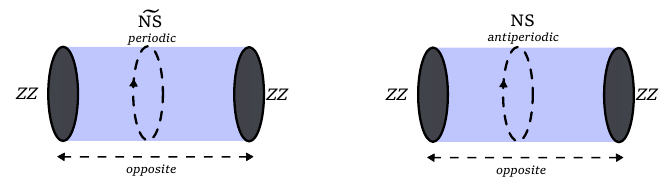
Figure 12 . Left: cylinder with g NS boundary conditions around the small circle, leading to super- symmetric quantum mechanics in 1d. Right: cylinder with NS boundary conditions around the small circle, leading to a removal of all fermions upon dimensional